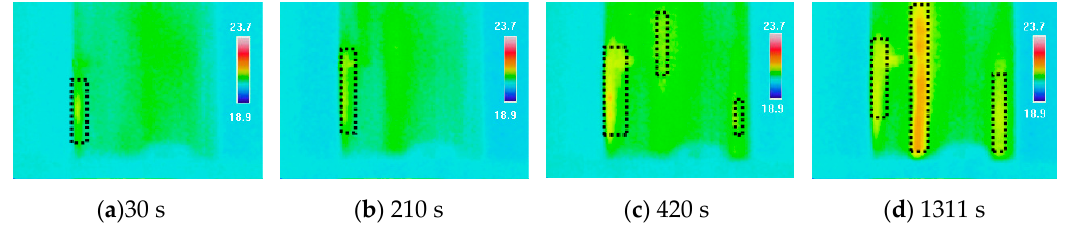
Figure 6. Thermal images of specimen A3 at different moments.